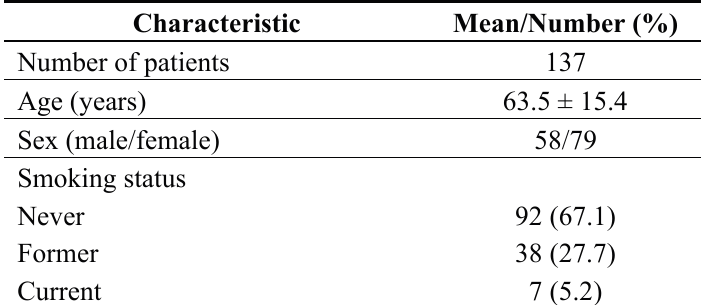
Figure 1. Patient selection flow chart, (PEF, peak expiratory flow). Table 1. Patients’